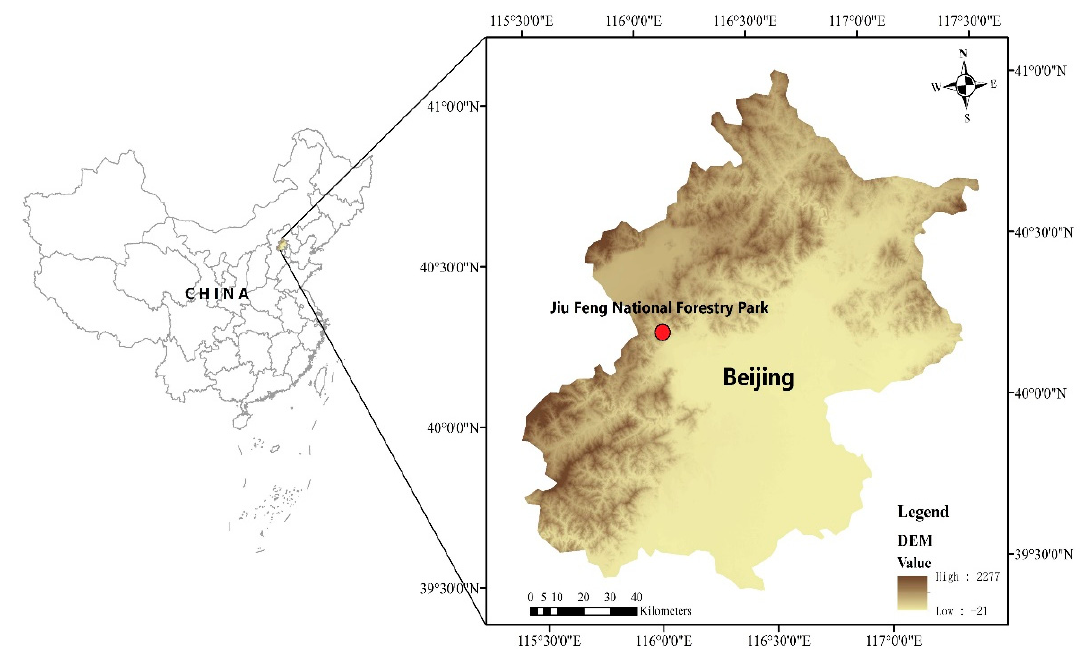
Figure 1. The location of Jiu Feng national Forestry Park in Beijing, China (Arc GIS10.0).